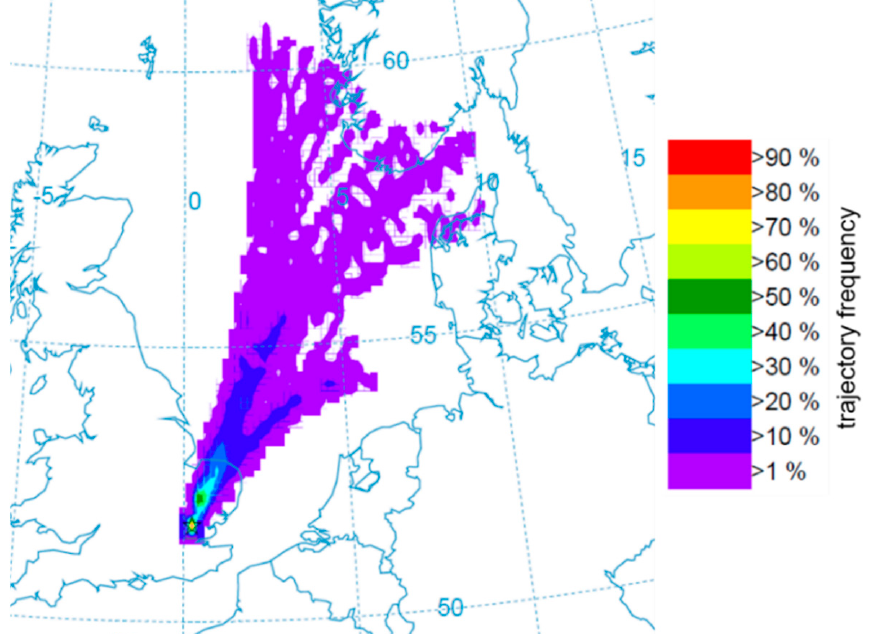
Figure 6. Back trajectory frequency plot for a sample record of P. xylostella from a light trap in Kimpton, Hertfordshire (yellow star). The colours indicate the likelihood of each 0.25° × 0.25° grid cell being the initial source location for a trajectory ending at Kimpton every 3 h from 10:00 on 30 May 2016 to 07:00 on 4 June 2016.